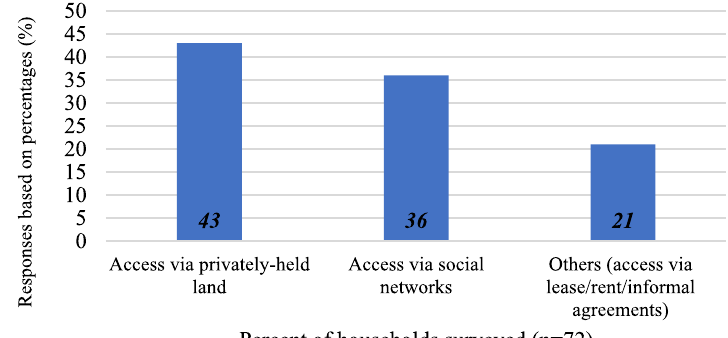
Fig. 2 Primary means of access to pasture during droughts among surveyed